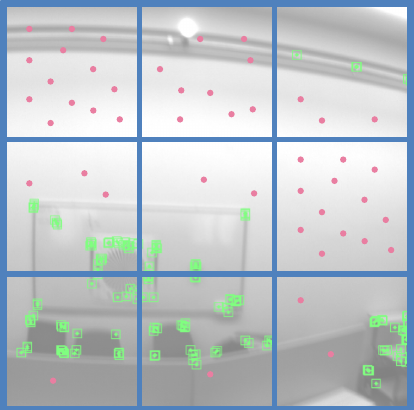
Figure 4. Illustration of the robust point sampling strategy for depth consistency residuals. The sampling method is based on the spatial distribution of 2D feature points in the divided image cells (3 × 3) and is inclined to sample more points from the featureless regions (green points are 2D feature points extracted by SLAM system for feature matching; red points are sampled points for depth consistency residuals). Notice that the depth consistency residuals are based on the randomly sampled points rather than 2D feature